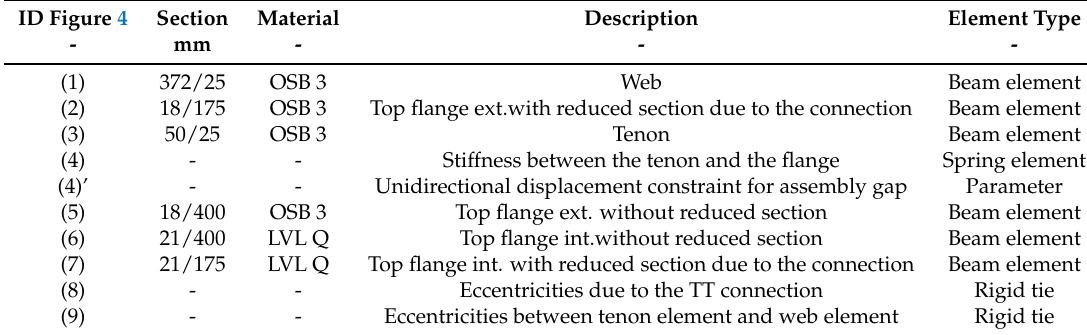
Table 2. Model properties according to Figure